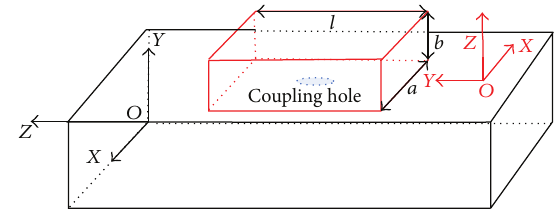
Figure 2: The equivalent resonant cavity of